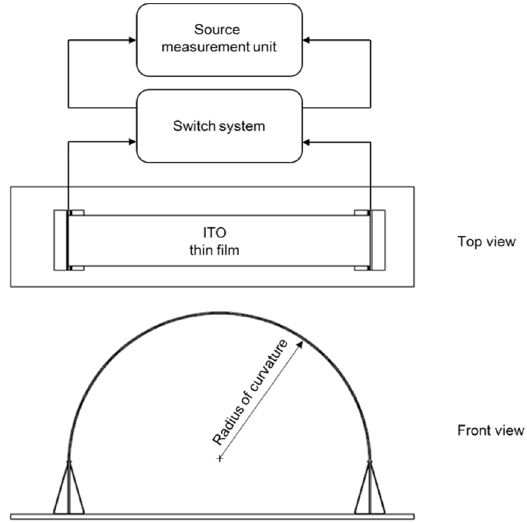
Figure 2. Schematic diagram of in situ measurement of electrical resistance during static bending test of ITO thin film.